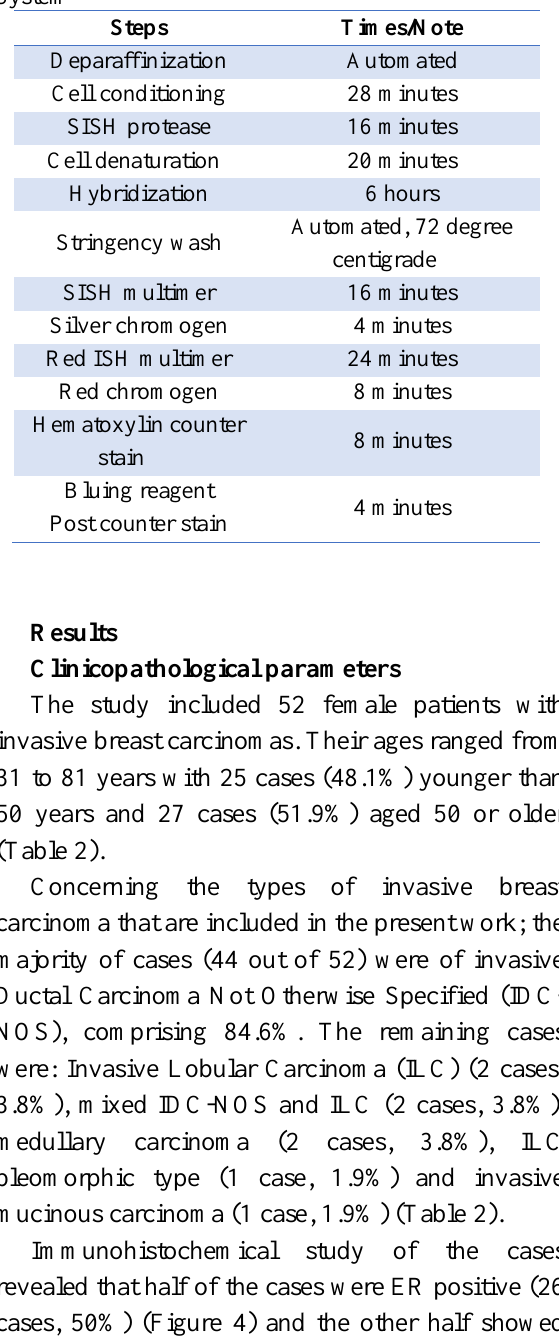
Table. 1. The Staining Protocol in Accordance With Standard Dual In Situ Hybridization Staining Protocol